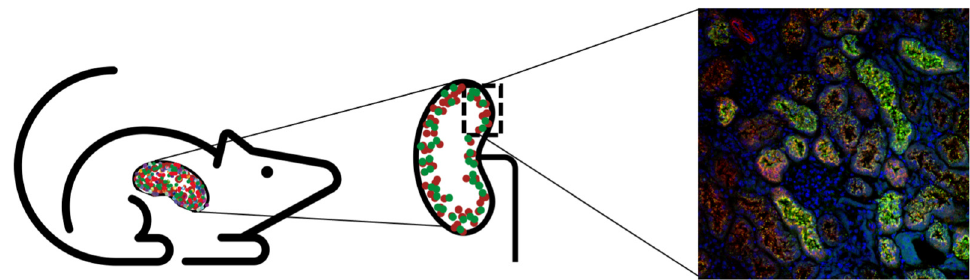
Figure 4. Uptake of A1M and the somatostatin analog octreotate was shown to co-localize on different levels [83]. First, SPECT showed uptake of both molecules in the kidney. Second, autoradiography indicated cortical uptake of both octreotate and A1M. Lastly, colocalization of A1M (green), octreotate (red), and DAPI (blue) was seen in the kidney cortex (magnification 20 ×).